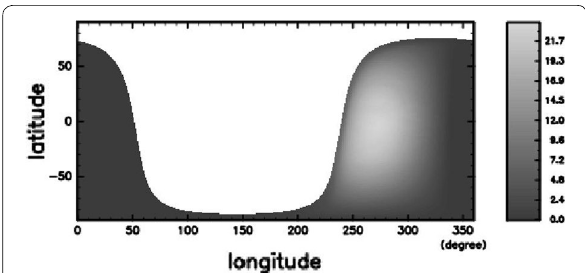
Fig. 11 An example of a Level 3 image: an image of Fig. 4b plotted on the planetary latitude–longitude coordinate. It is not corrected for limb darkening. The right vertical gray bar is for radiance in unit of mW/cm 2